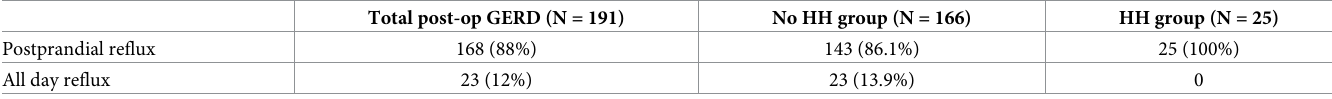
Table 3. Subgroup analysis of patients with post-op GERD.